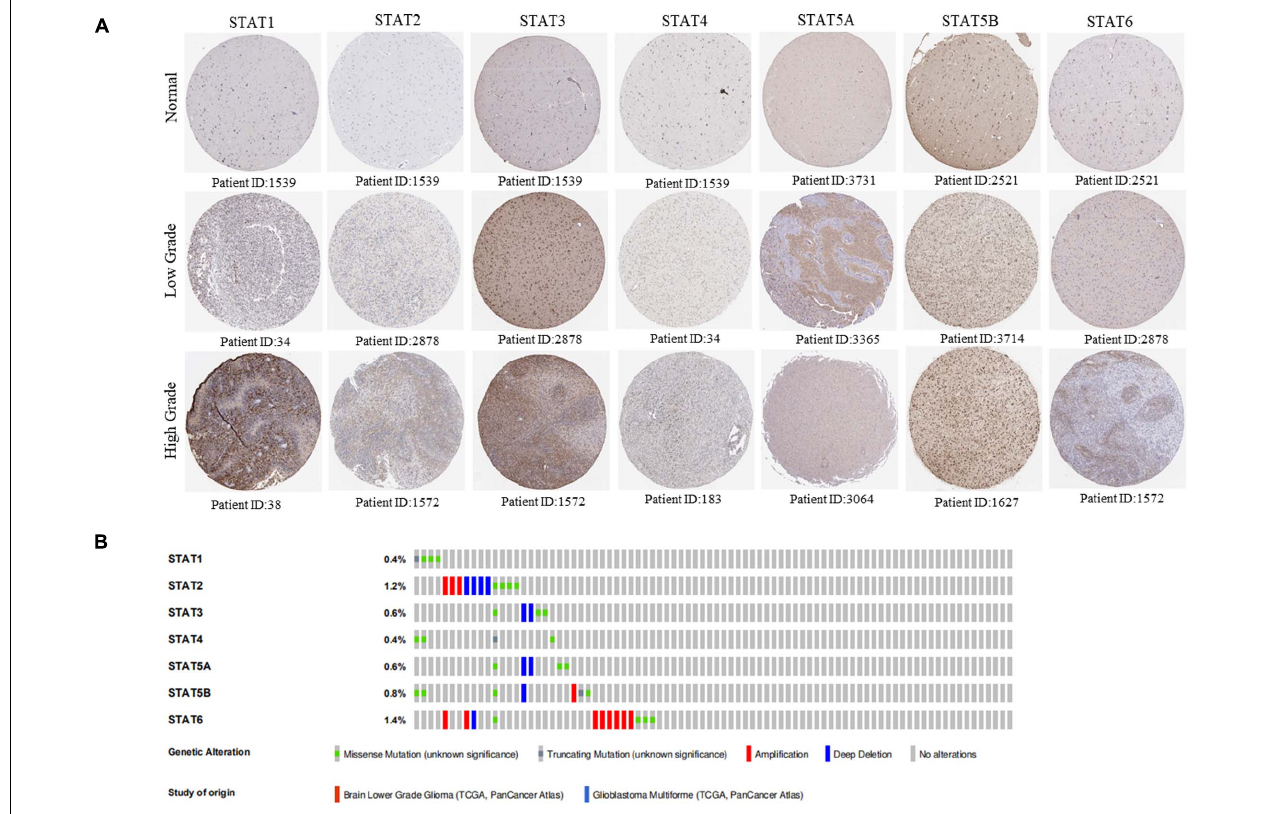
FIGURE 4 | Protein expression level and genetic alteration of STATs in glioma . (A) The protein expression of STAT genes in glioma (low grade and high grade) and normal brain tissues using human protein atlas database. (B) Genetic variations of STAT genes in glioma using